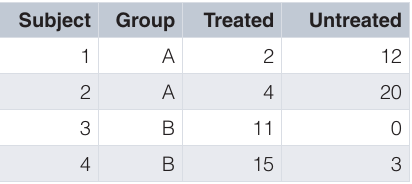
Table 3. A hypothetical paired-samples RNA-seq